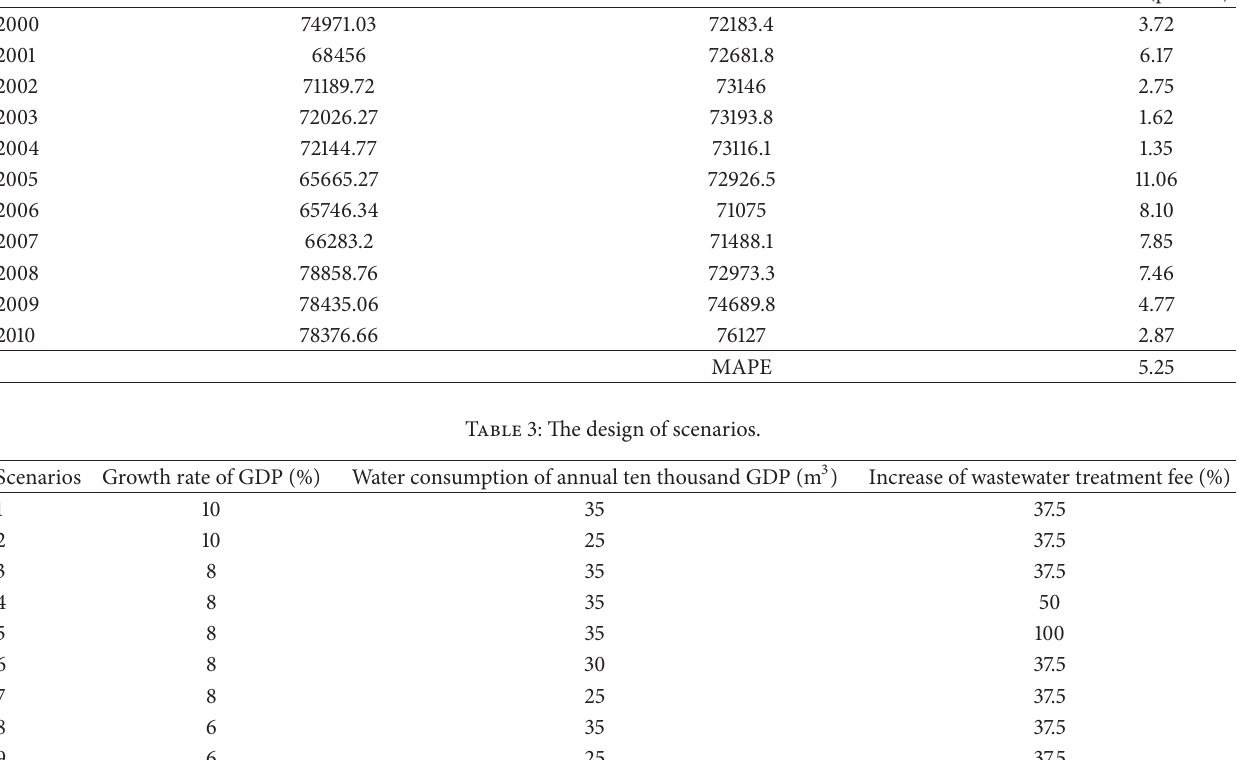
Table 2: The comparison of the real value and the simulation value.